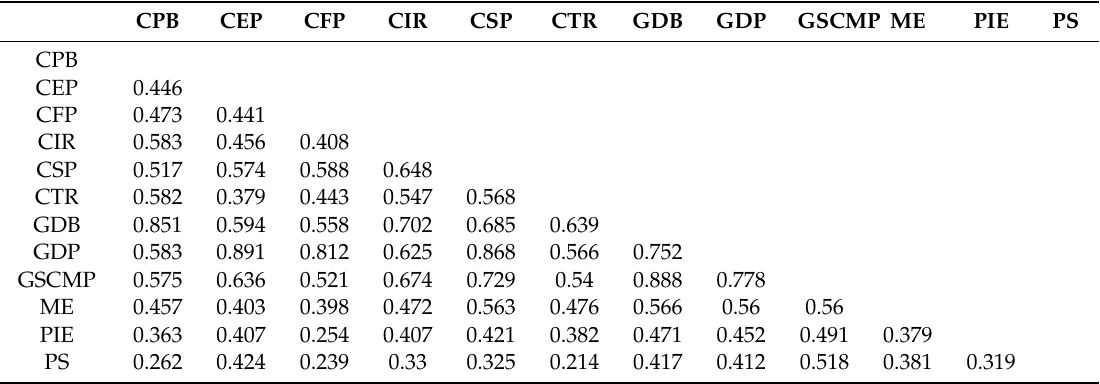
Table 4. Heterotrait–monotrait ratio (HTMT) values.